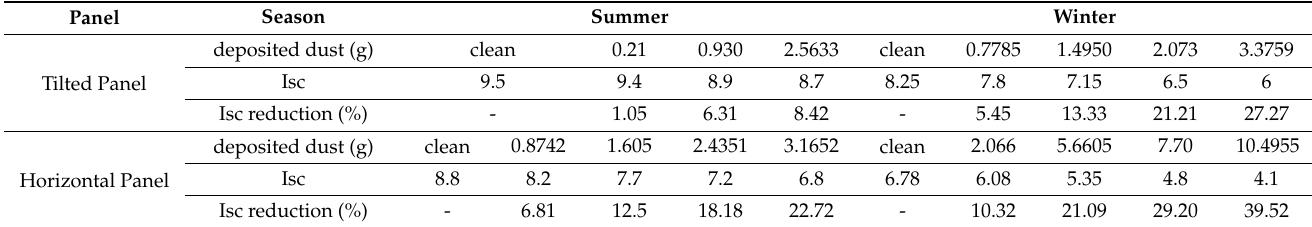
Table 3. Short-circuit current variation in terms of dust deposition.